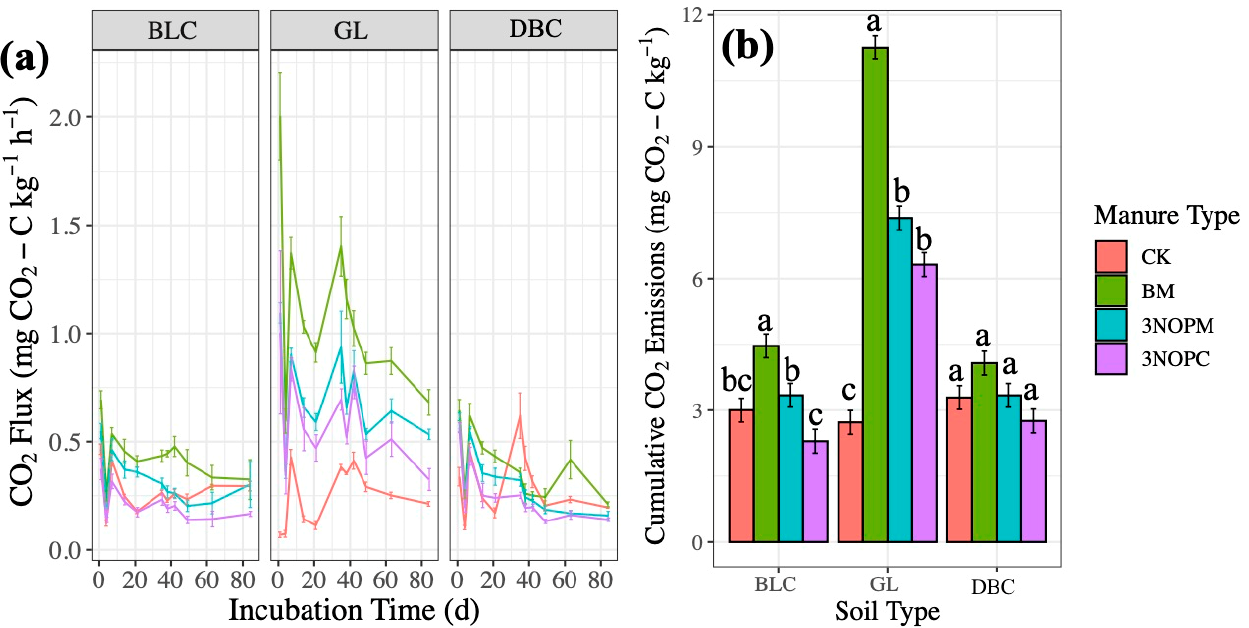
Figure 1. Effects of manure type on CO 2 emissions ( a ) over time by soil type and ( b ) cumulatively by soil type in a laboratory incubation experiment. Soil type: BLC, Black Chernozem; GL, Gray Luvisol; DBC, Dark Brown Chernozem. Manure type: CK, control with no amendments; BM, barley ‐ based manure; 3 ‐ NOPM, manure from cows fed 3 ‐ NOP supplement; 3 ‐ NOPC, composted manure from cows fed 3 ‐ NOP supplements. Treatments that do not share the same letter are significantly different from each other. Error bars indicate standard errors of the means ( n = 4).